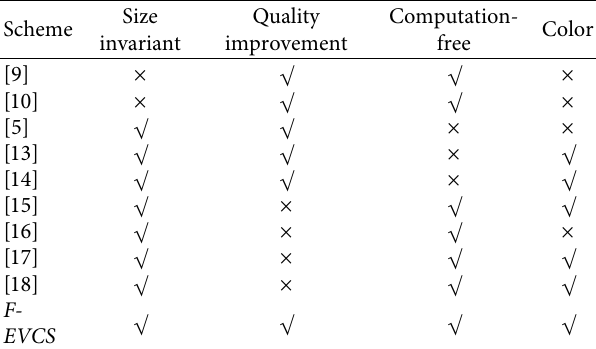
Table 1: Feature comparisons among our proposal and previous